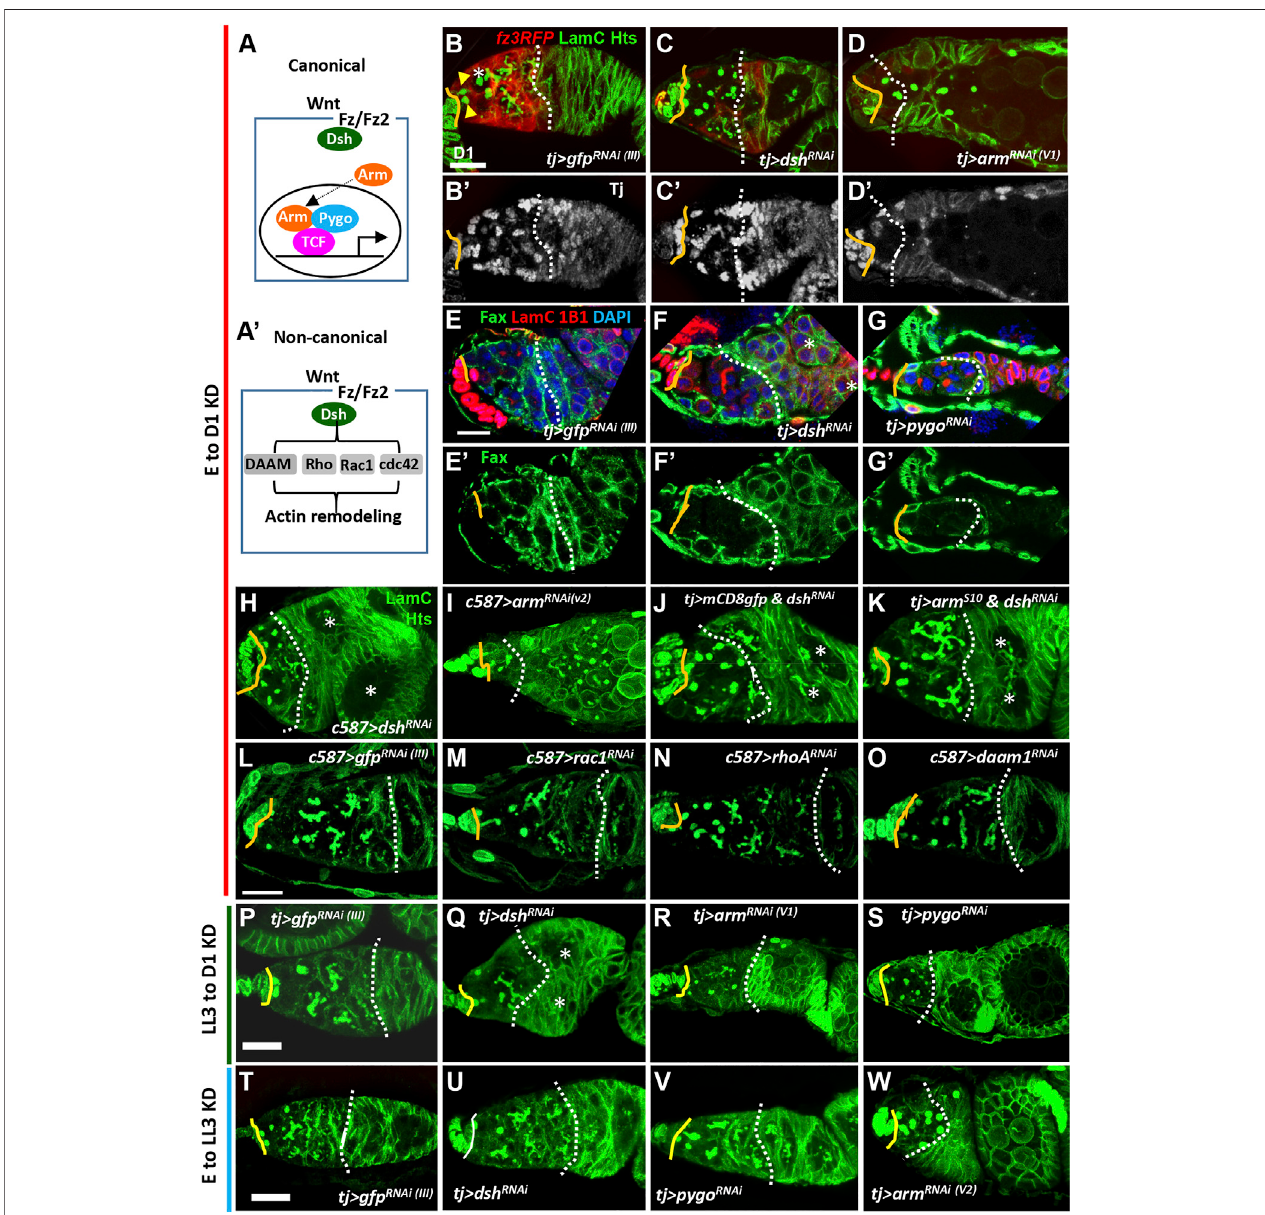
FIGURE2| CanonicalWntsignalinginthedevelopingsomacontrolsescortcellformationandpromotesgermcelldifferentiation. (AandA ’ ) Canonical(A)andnon- canonical Wnt signaling pathways (A ’ ) . Wnt signaling components were knocked down in the ovarian soma from embryo to adult day (D)1 (B – O) , from late-L3 (LL3) to adult D1 (P – S) , and from embryo to LL3 (T – W) , and D1 germaria were examined. (B – O) tj-GAL4 > gfp RNAi (III) (B and E) , tj > dsh RNAi (C and F) , tj > arm RNAi (V1) (D) , tj > pygo RNAi (V) (G) , c587 > dsh RNAi (H) , and c587 > arm RNAi(V) (I) , tj > mCD8-gfp & dsh RNAi (J) , tj > arm S10 & dsh RNAi (K) , c587 > gfp RNAi (III) (L) , c587 > rac RNAi (M) , c587 > rhoA RNAi (N) and c587 > daam1 RNAi germaria (O) withLamC(greeninB – DandH – O,redinE – G,terminal fi lament(TF)andcapcellnuclearenvelopes),Hts(greenin B – DandH – O,redinE – G,fusomes),Tjin (B ’ toD ’ ) (gray,nucleiofcap,escortandfolliclecells),Fax(greeninE-G,ECmembranes),andDAPI(blueinE-G,DNA). (E ’– G ’ ) show only Fax channel. (P – S) tj-GAL4 > gfp RNAi (III) (P), tj > dsh RNAi (Q) , tj > arm RNAi (V1) (R) and tj > pygo RNAi germaria (S) with LamC (green) and Hts (green). (T – W) tj- GAL4 > gfp RNAi (III) (T) , tj > dsh RNAi (U) , tj > pygo RNAi (N) and tj > arm RNAi (V2) germaria (W) with LamC (green) and Hts (green). Solid lines, GSC-cap cell junction; dashed lines, the 2A/2B boundary (or the junction between escort cells and follicle cells when 2A/2B boundary is missing). Arrowheads and an asterisk in panel 2B respectively mark GSCs andcystoblast.Twoasterisks inF,H,K,and Qdenotetwoside-by-side eggchambers intheovariole.Scale bars are10 μ m; B-Dand H – K,E – G,L – O,P – S, and T – W have the same scale